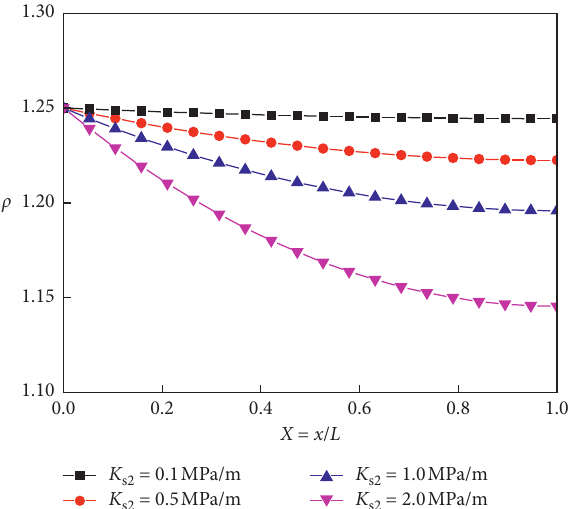
Figure 17: Effect of the interfacial frictional resistance at stage III on K